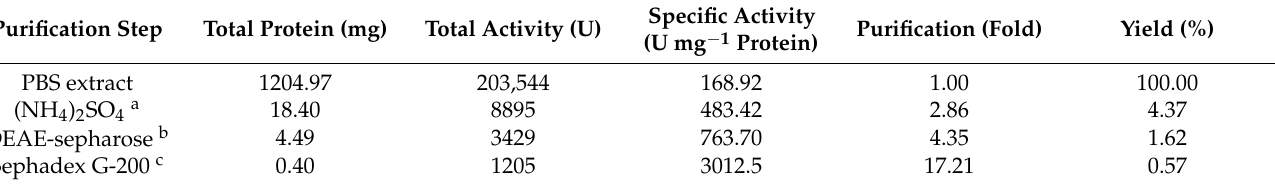
Table 1. Purification of polyphenol oxidase from Huaniu peel.